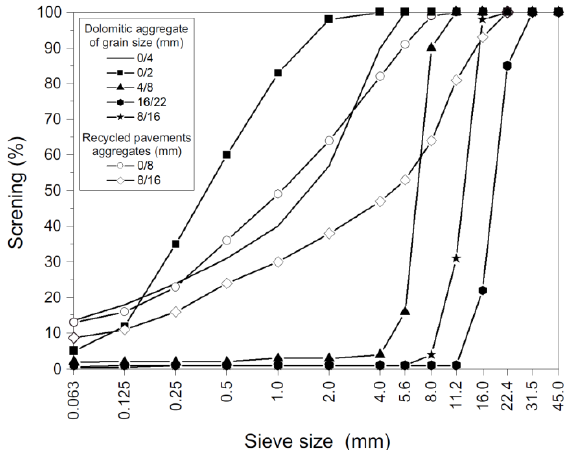
Figure 1. Grain size curves for the applied aggregates.